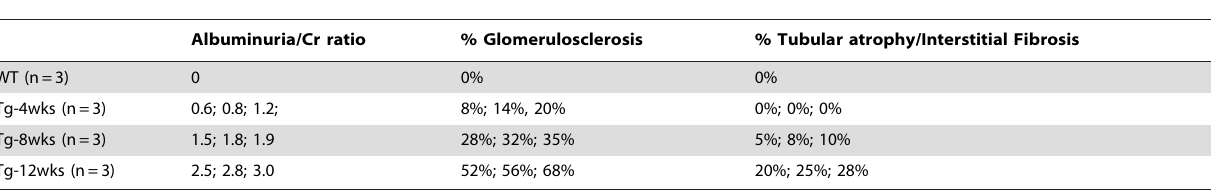
Albuminuria/Cr ratio % Glomerulosclerosis